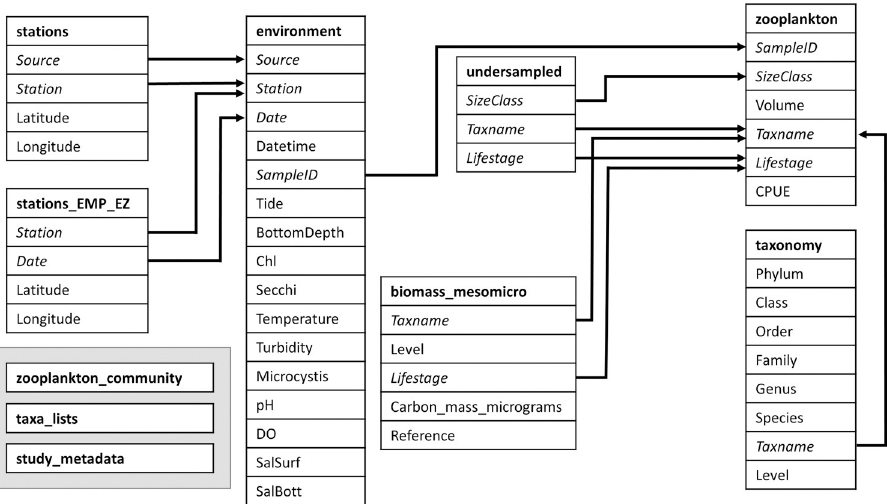
Fig 3. Linkages among the main data tables. Table names are in bold and keys are in italics and connected by arrows. Only tables linked to the zooplankton table are shown in full detail, others are listed in the gray box. The zooplankton_community table is composed of the other linked tables (except biomass_mesomicro) joined together and its taxonomic resolution has been standardized. The taxa_lists table contains the list of taxa identified in each survey and net size, along with dates when taxa lists changed and species introduction years. The study_metadata table contains information on each component survey. Descriptions of variables are given in Tables 3 and 4.